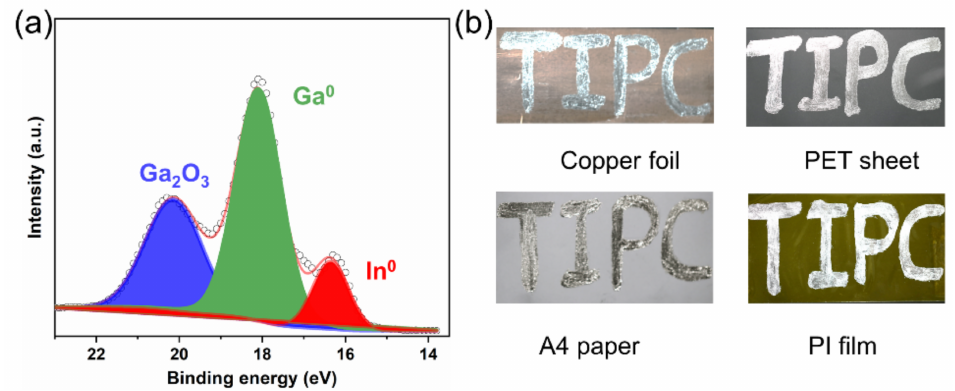
Figure 3. ( a ) The composites and valence states of LM-O 60 obtained by XPS analysis. ( b ) The printing performance of LM-O 60 on the diverse